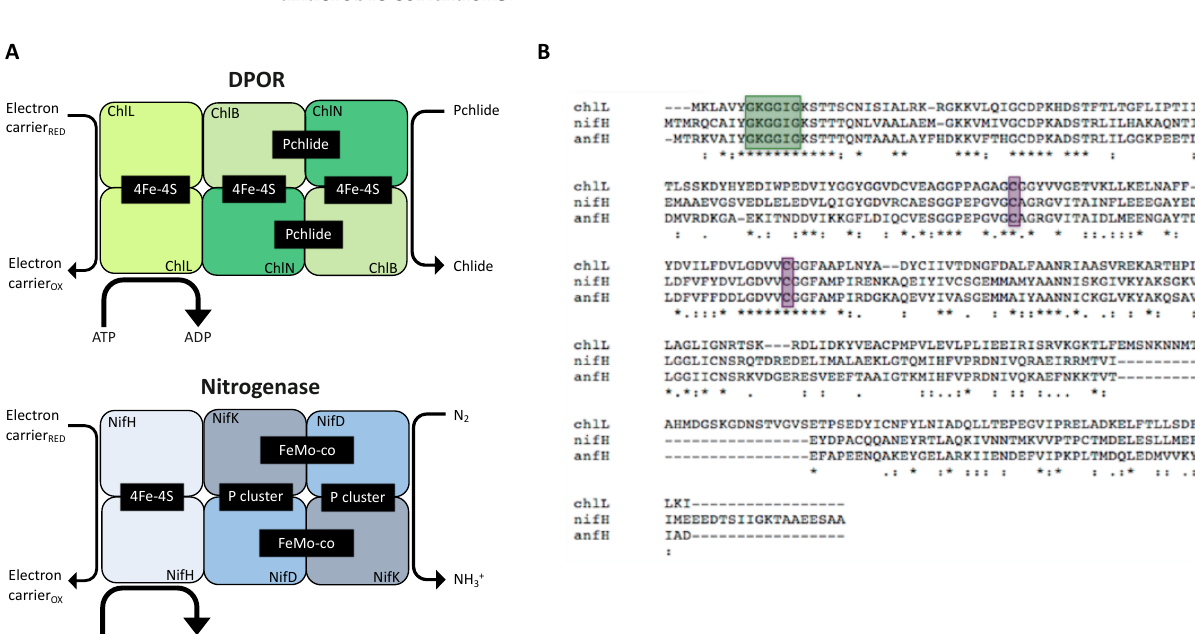
Figure 3. Subunit comparison of DPOR and nitrogenase. ( A ) Chlorophyll synthesis in the dark involves the reduction of the precursor molecule protochlorophyllide (Pchlide) to chlorophyllide (Chlide) by the nitrogenase-like DPOR (composed of subunits ChlL, ChlN, and ChlB) (upper panel). The nitrogenase complex is made of the homologous subunits NifH, NifD, and NifK and reduces N 2 to NH 3+ (Lower panel). Both enzymes rely on protein–protein interaction between their sub-complexes. The heterotetrametric proteins (ChlN/ChlB, NifD/NifK) interact with the dimeric component (ChlL, NifH) in an ATP-dependent fashion. Redox-active metal clusters allow electron transfer to the substrates to generate the final product (Chlide, NH 3+ ). ( B ) Protein sequence alignments of the reductases ChlL from C. reinhardtii , NifH from K. oxytoca and AnfH from A. vinelandii . The three enzymes display the conserved cysteine groups (purple) that are required as ligands for the [4Fe-4S] clusters; the motif responsible for nucleotide binding is shown in